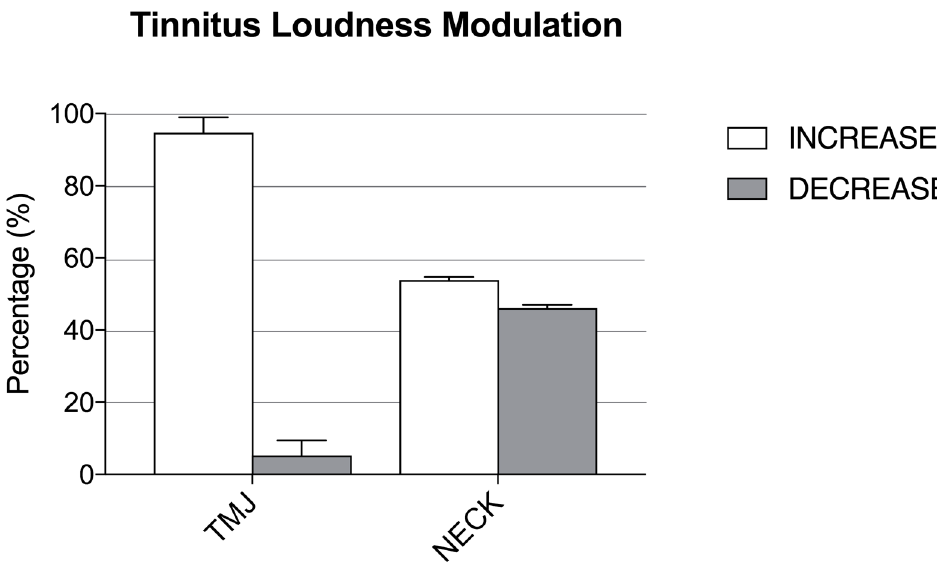
Fig 4. Tinnitus loudness modulation. Percentages patients that could increasesor decreasethe loudness of their tinnitus with temporomandibularjoint (TMJ) or head and neck (NECK) maneuvers. Significantly more TMJ maneuvers increasedtinnitus loudness(99.83% in the ST+HY group; 90.69%in the ST group) than decreased loudness(p < 0.001).These findingsare consistent with a previous study of our group on 310 tinnitus patients and with other authors who found a prevalentincreaseof loudnessfollowingTMJ maneuvers and a prevalentdecrease followingNECK maneuvers